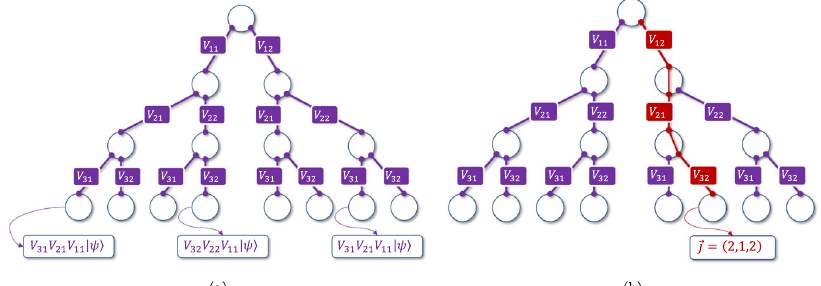
Fig. 2 Operator tree. a The operator tree spanned by a binary example ( k = 2) of V for three time steps with the edges named. Each edge represents a state transformation from a parent node to a child node, and each node represents a quantum state. Three states at the fi nal leaves starting from an initial state ψ j i at the root node are explicitly shown as an example. b The path j = (2, 1, 2) ⊤ ∈ K 3 and the operator U ( j ) = V 32 V 21 V 12 are shown as an example.